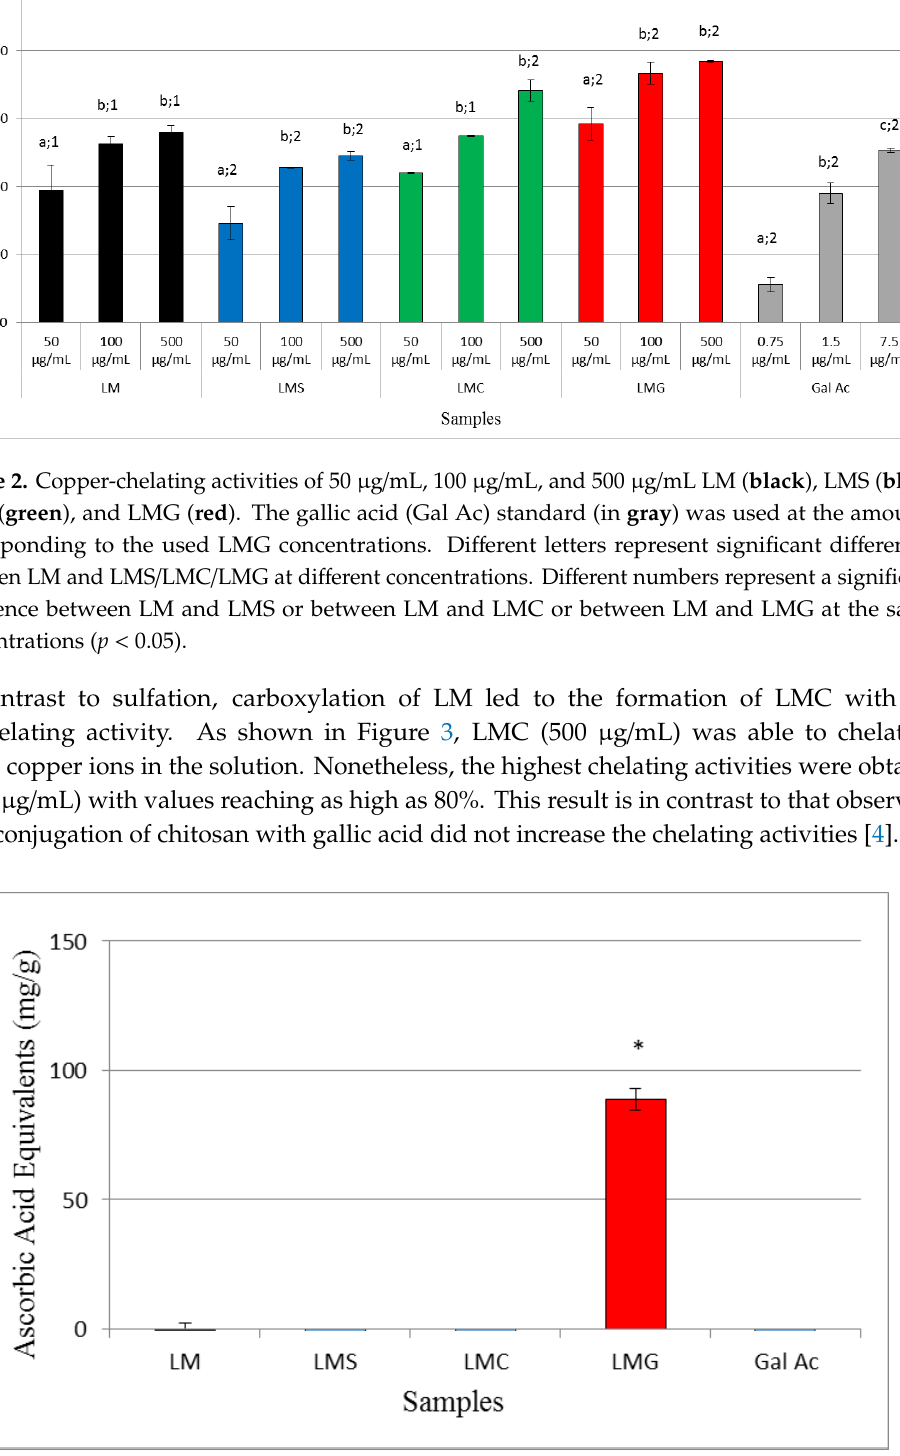
Figure 3. Total antioxidant activities of 100 µg LM ( black ), LMS ( blue ), LMC ( green ), LMG ( red ), and gallic acid (Gal Ac.). The asterisk (*) represents a significant difference between LM and another sample ( p < 0.05).